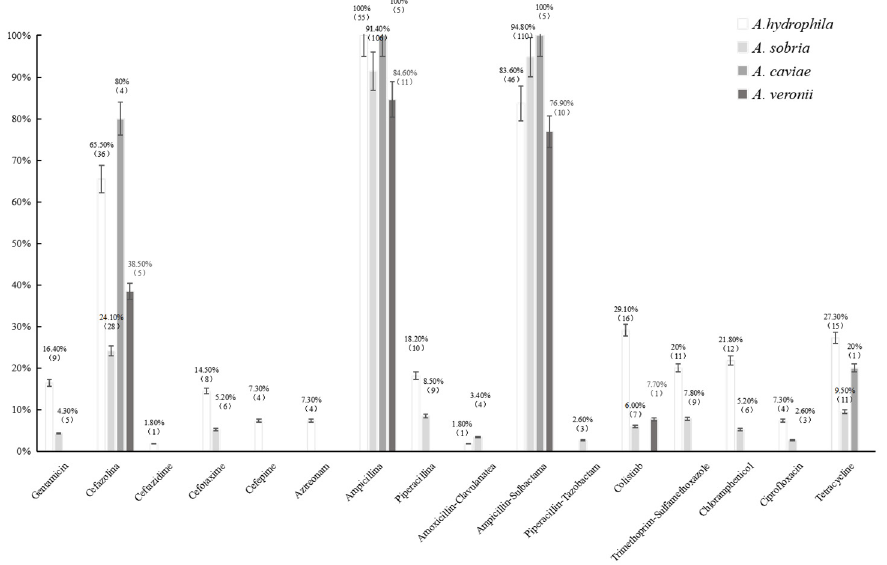
Figure 2. The distributions of antimicrobial susceptibility, to the antibiotics tested, of A. sobria , A. hydrophila , A. veronii , and A. caviae isolated from migratory bird samples are presented. Univariate ANOVA revealed that the difference between groups was highly significant for each antibiotic. Other pairwise comparisons within each group were significant.